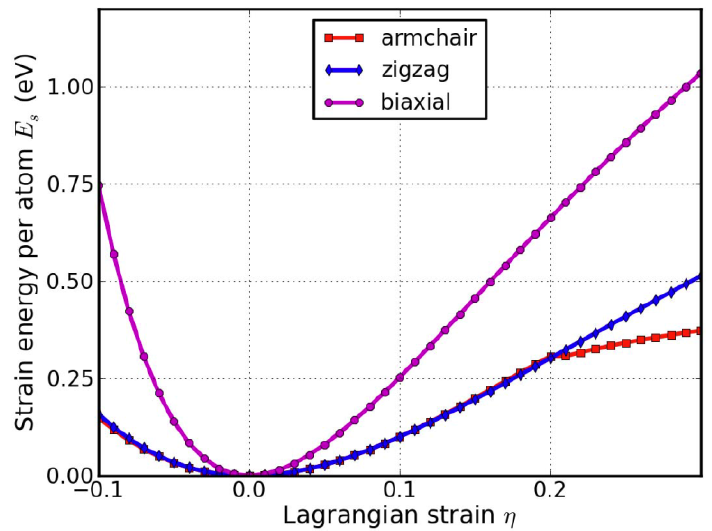
Figure 22. Energy–strain responses for uniaxial strain in armchair and zigzag directions, and biaxial